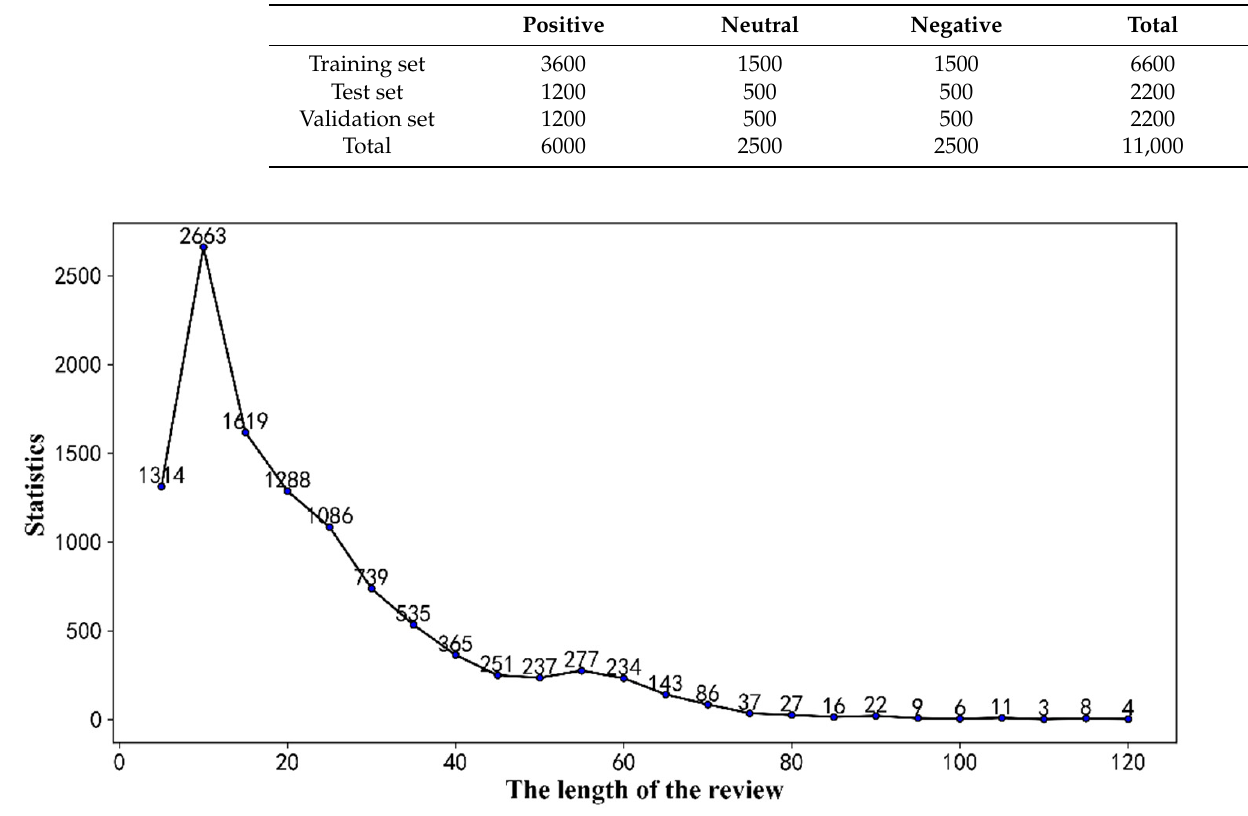
Table 1. Text data information.